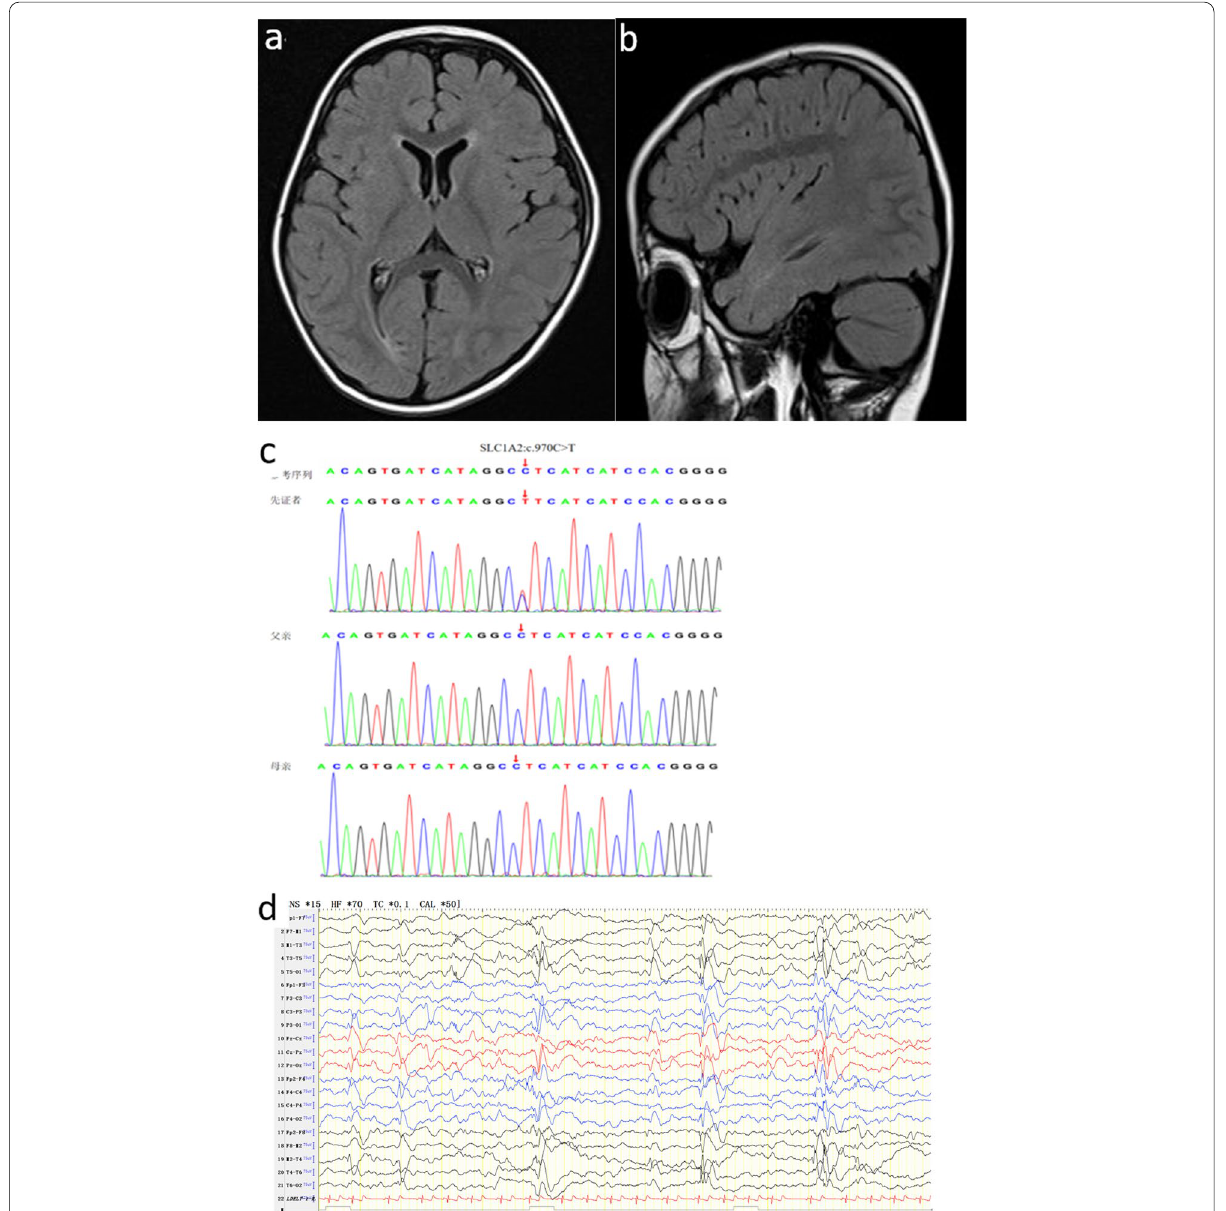
Fig. 2 Brain MRI, EEG and Sanger sequencing of patient 1. a Axial T2 flair images showed abnormal signals around bilateral lateral ventricles, multiple small polygyrus in double occipital lobes and obviously on the posterior horn of right lateral ventricle. b The boundary of he gray and white matter of the left parietal and temple lobe is unclear in sagittal position. c Scalp EEG. Medium- to high-amplitude, irregular sharp slow waves and spike slow waves can be seen in each lead of bilateral hemispheres during the interictal period. d Sanger sequencing verified c970C > T de novo mutation of SLC1A2 , while her parents were wild type at this